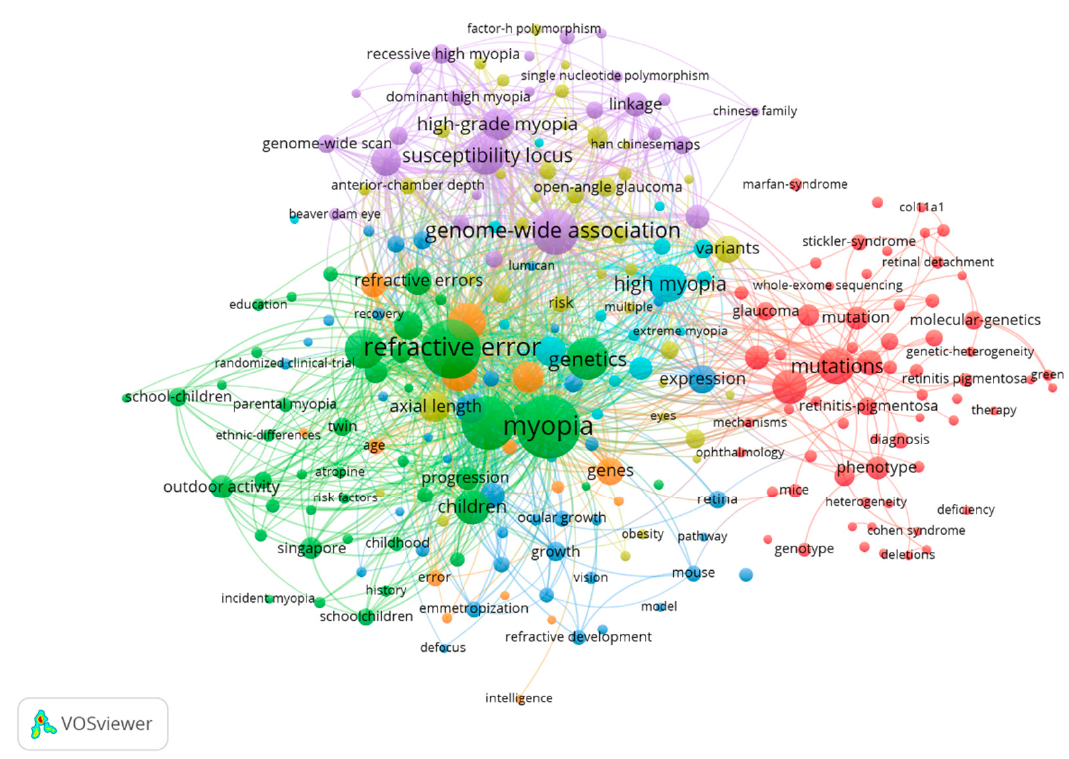
Figure 6. Connection between keywords.